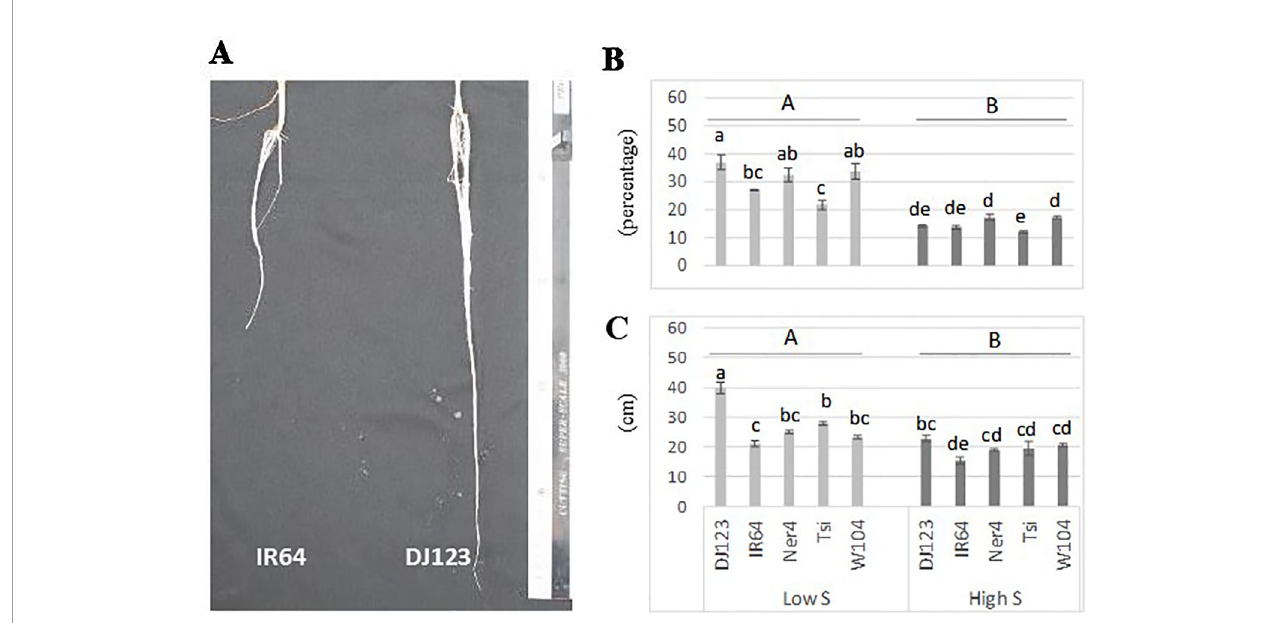
FIGURE 1 | Root elongation (A) , root:shoot ratio (B) and root length (C) of rice plants grown under low-S and high-S treatment. Data represent the mean (± standard error, SE) of three independent replications (n=3) and analyzed by two-way ANOVA. Different letters indicate signi fi cant difference within either factor: S treatment (capital letter) or genotype (small letter) according to Tukey's Honest Signi fi cant Difference test ( P < 0.05). ANOVA results are provided in Supplementary Table S4 - 1 in Data Sheet 1 . Cultivars, DJ123; IR64; Ner4, NERICA4; Tsi, Tsipala; W104, WAB56-104.